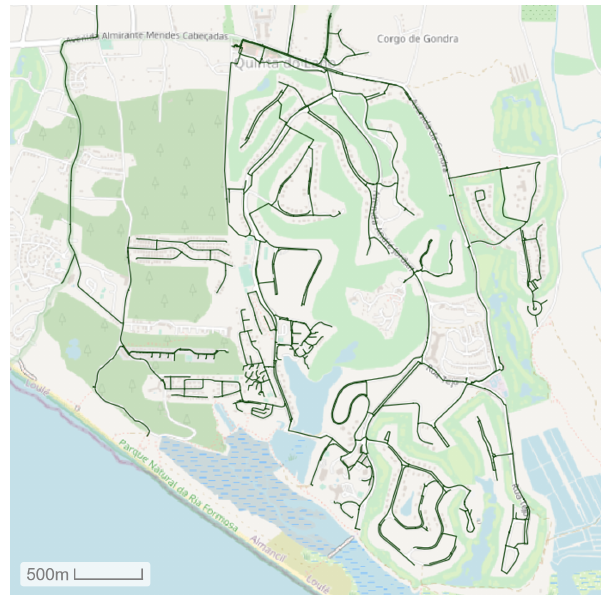
Figure 7. Water Distribution System of Quinta do Lago. (Adapted from